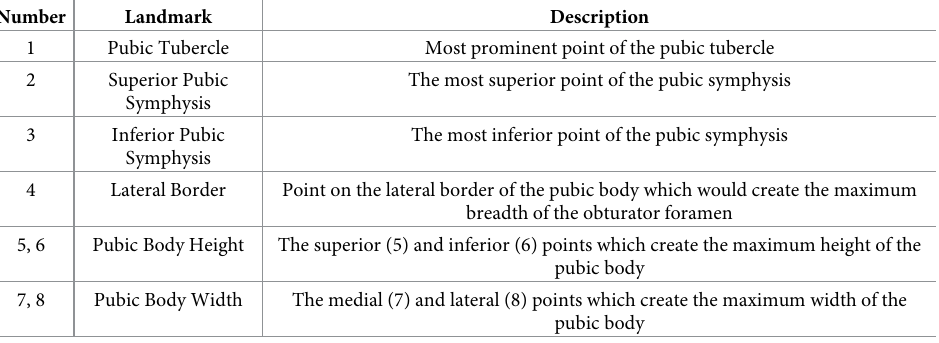
Table 1. Description of the location and landmark type of the eight landmarks recorded on each